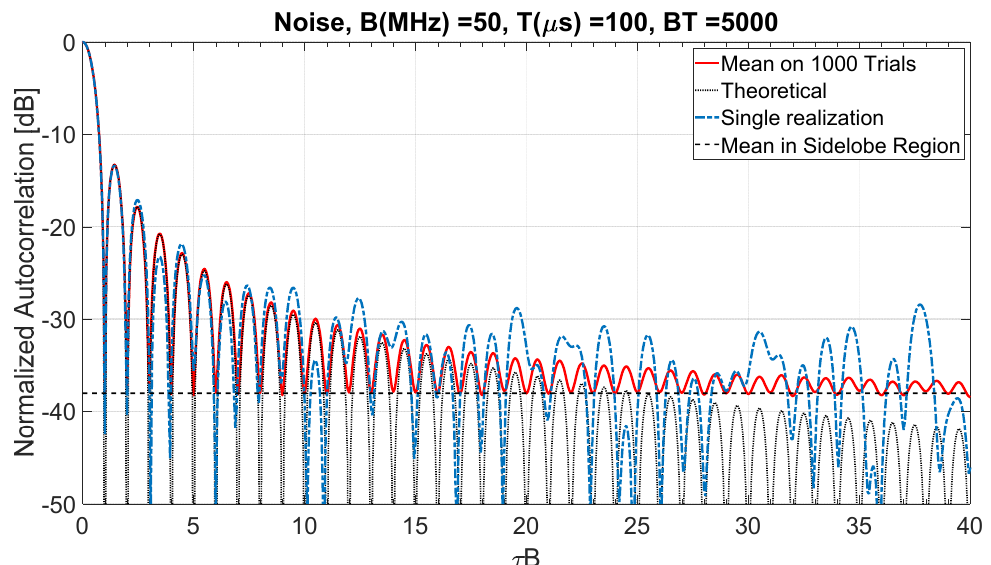
Figure 5. Normalized autocorrelation of a single realization: comparison between the single realization, the sample mean, and the theoretical value.